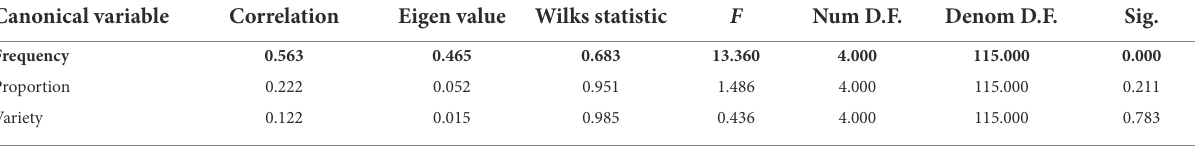
TABLE 3 Summary of the canonical correlation analyses: FSs and speed